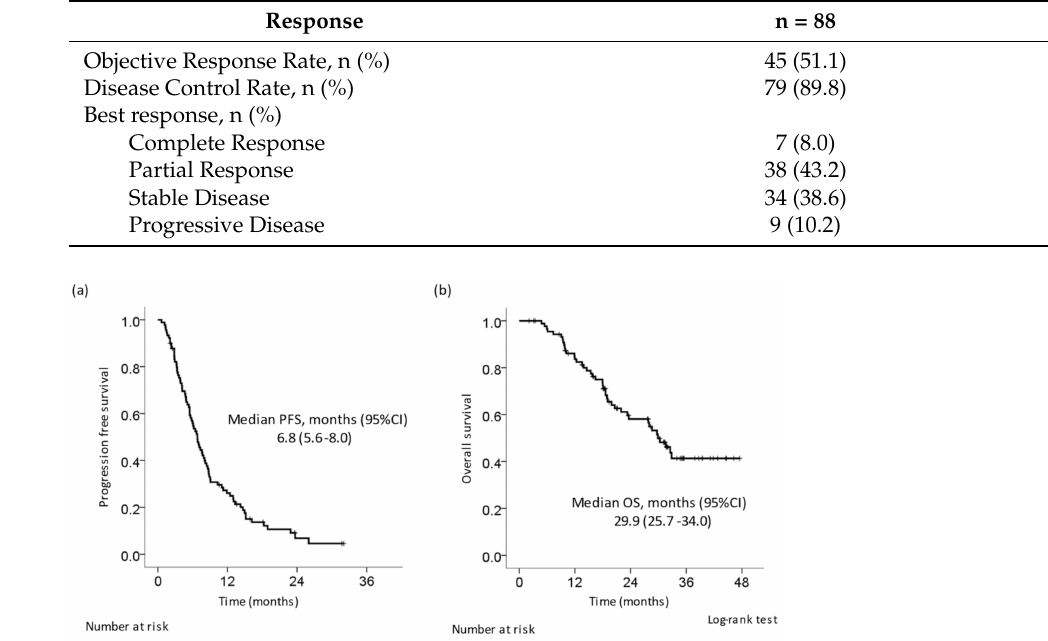
Table 2. The best response to lenvatinib, according to mRECIST.